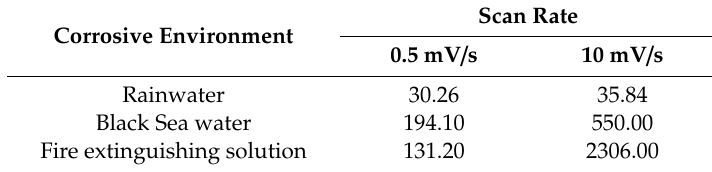
Table 10. Comparison between corrosion rates (v cor -in µ m / year) for the II-Zn / Fe sample. Corrosive Environment